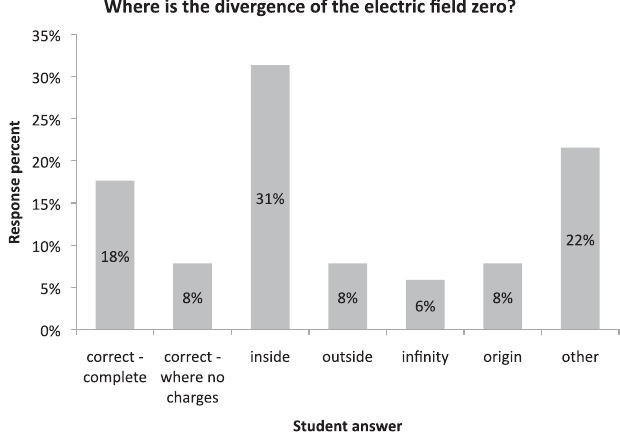
FIG. 4. Student response to a midterm question about a thin shell of uniform charge. N ¼ 51